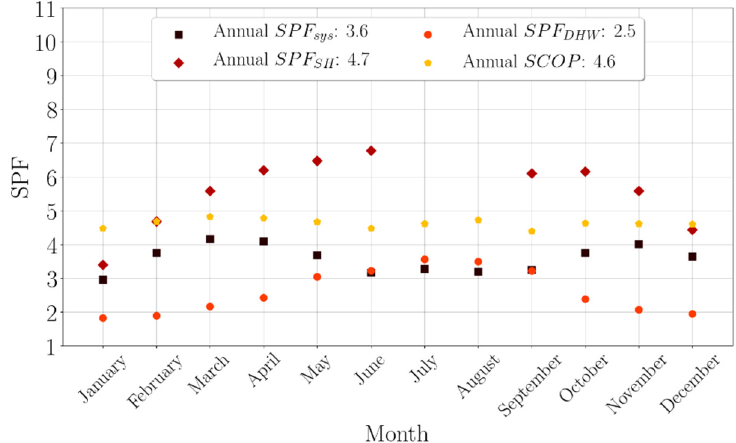
Figure 10. Performance factors and seasonal performance factors of the system.